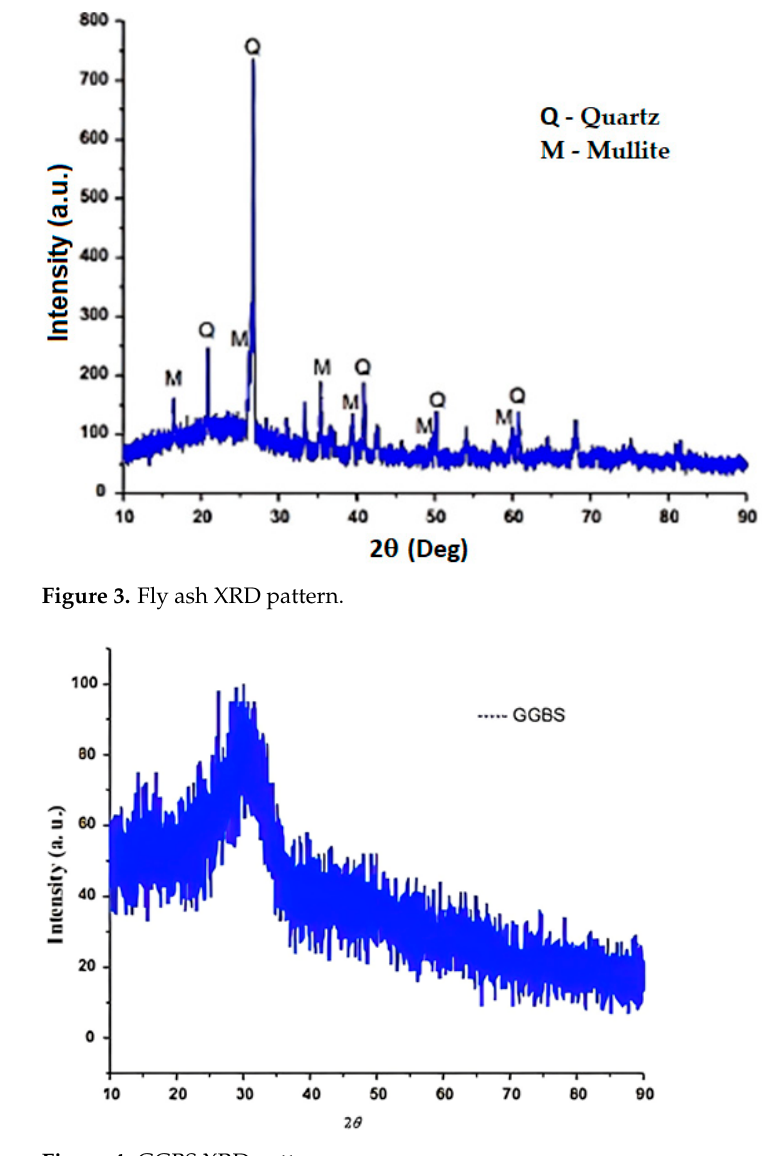
Figure 4. GGBS XRD pattern.